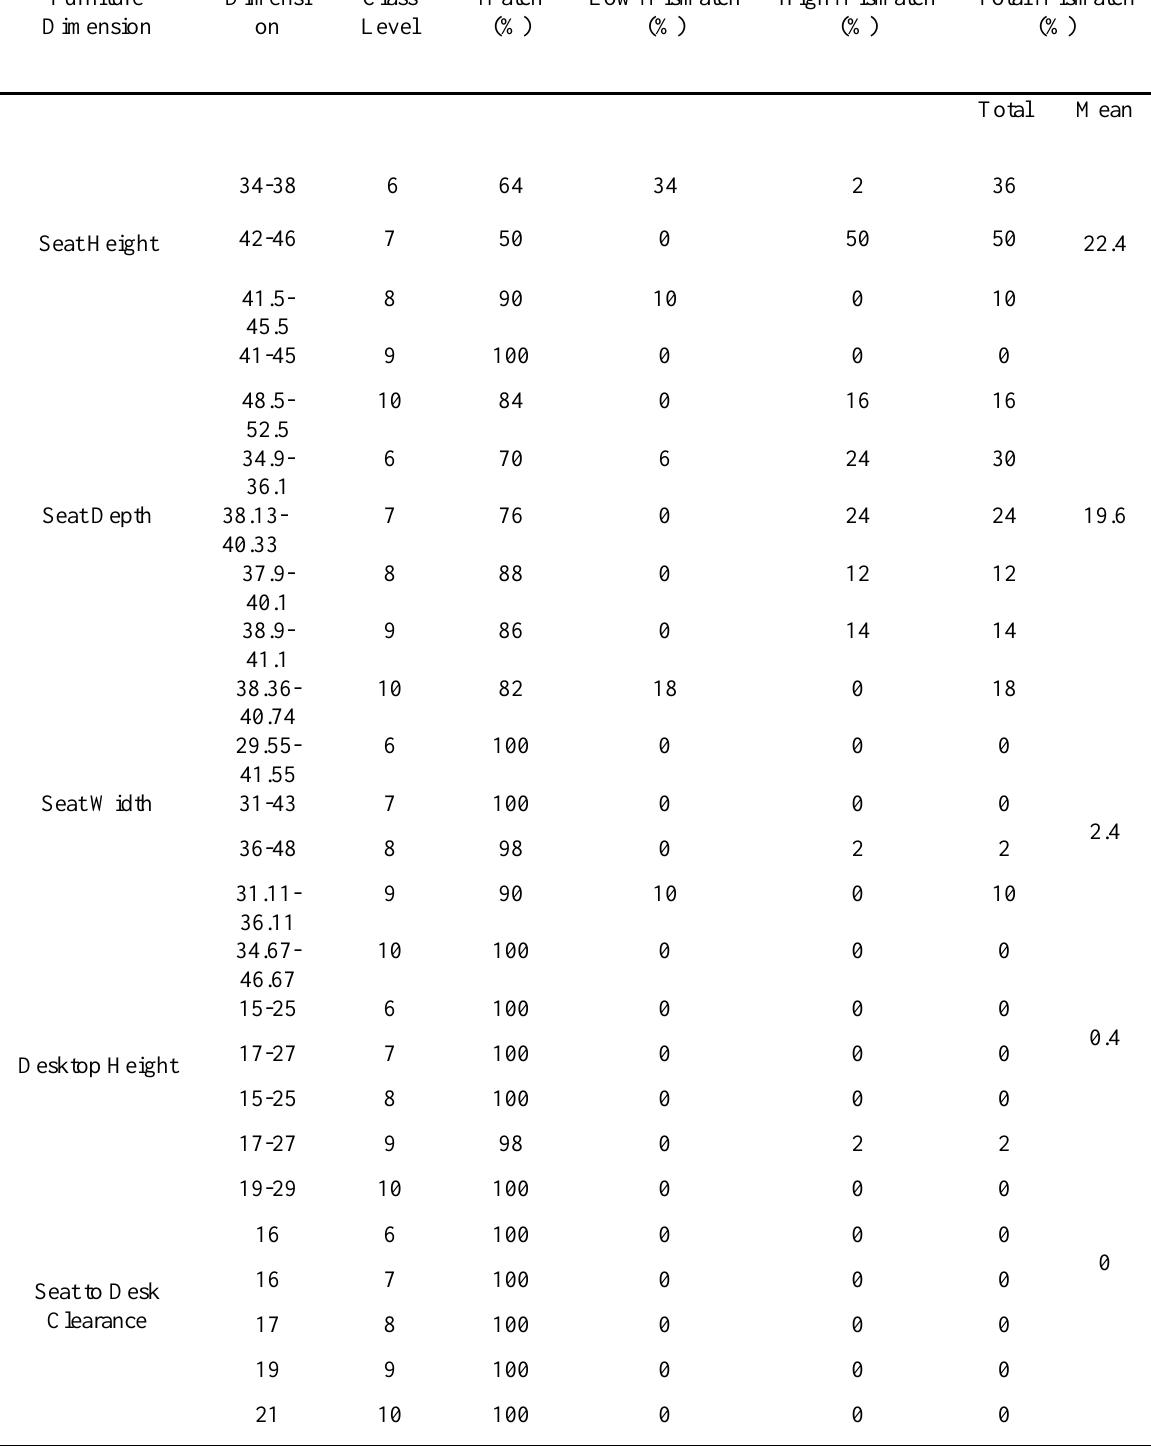
Table 5. Proposed dimensions (cm) for benches match/mismatch percentages for school students. Furniture Dimension